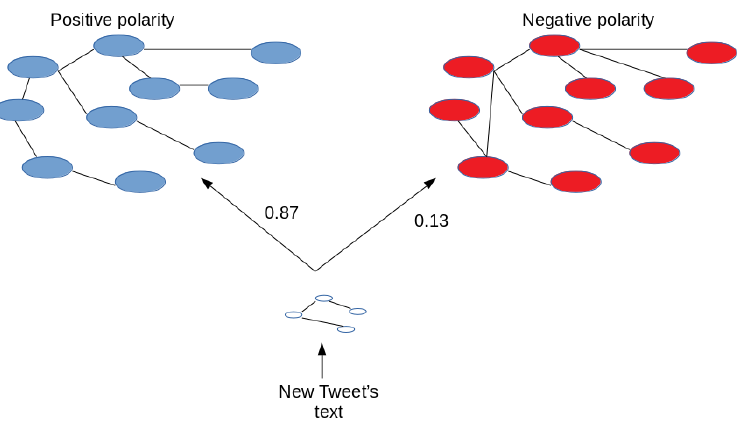
Figure 7. Similarity